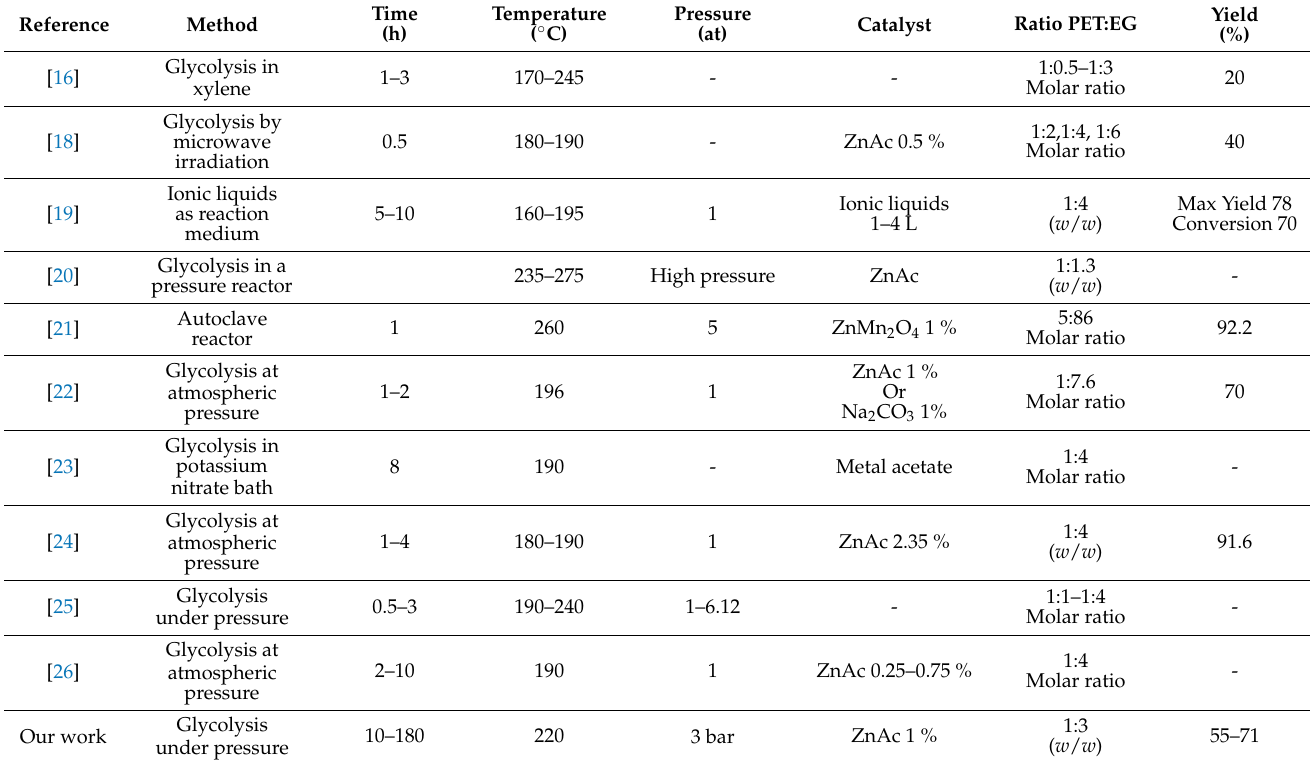
Table 1. Comparative between depolymerization procedures found in the literature and other present